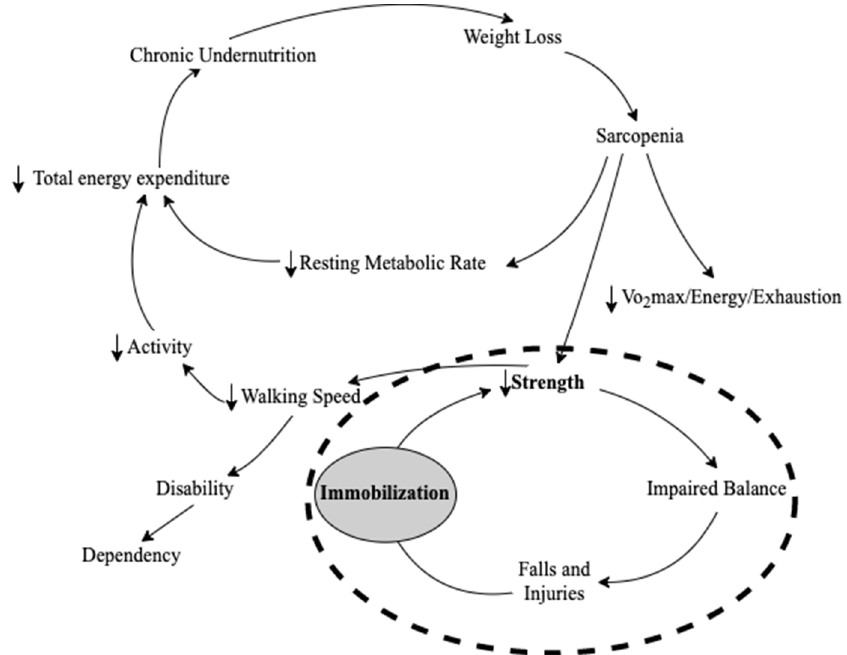
Figure 1. The cycle of frailty, adapted with permission from Ref. [29]. Copyright 2022